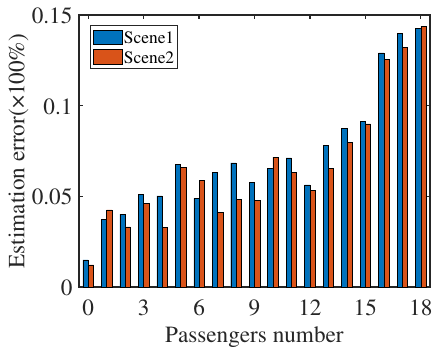
Figure 14. Estimation error in different